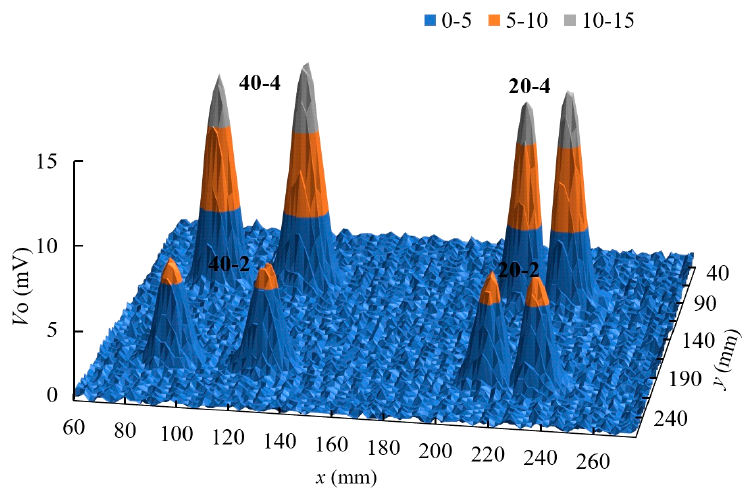
Figure 12. Measurement results of the butterfly probe with scanning 2 in x-y area.